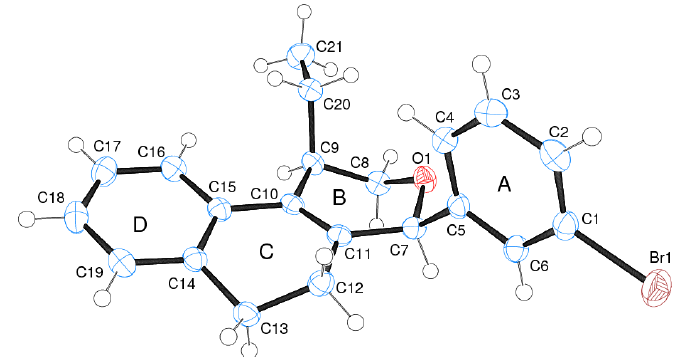
Figure 2. ORTEP-3 view of 15e (1 R ,4 S -conformer) showing the atom labeling, configuration of the chiral atoms and 50% probability ellipsoids. H atoms are shown as spheres of arbitrary